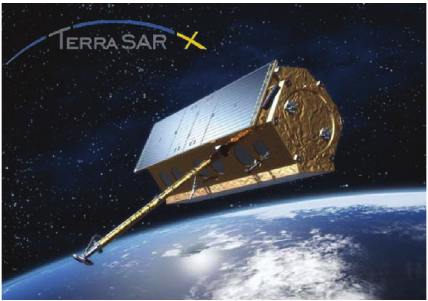
Figure 15: TerrasarX (Astrium Ge) [7]